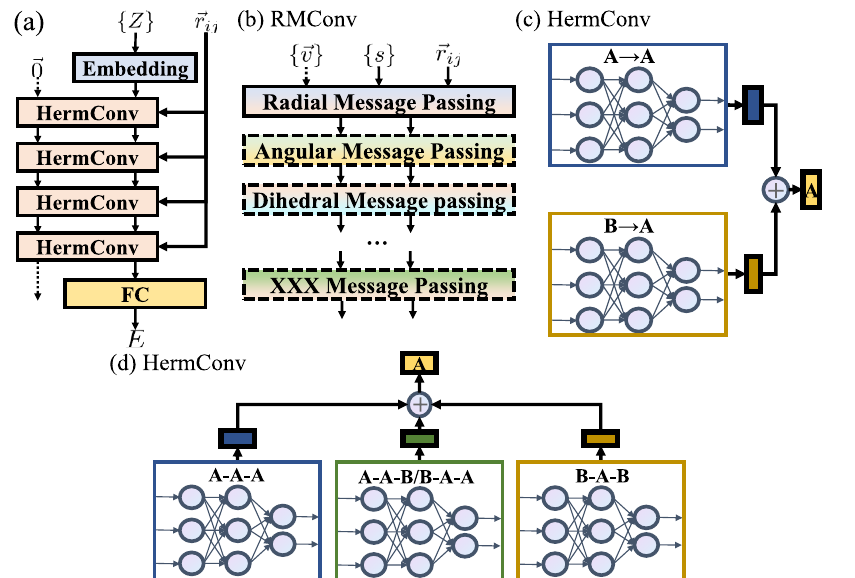
Fig. 2 The schematic of the working principle of the entire architecture. a The entire architecture diagram of HermNet where { Z } is the set of atomic numbers, which will be passed through an embedding layer. Initial vectorial node features are all-zero vectors of fi xed dimension. This layer is expected to receive a scalar node feature { s }, a vectorial node feature, and a vectorial edge feature, i.e. relative position vector r and then output an updated scalar and vectorial node feature as the inputs of the next layer. The fi nal scalar node features will be passed to a global pooling layer as feature of the graph. With the graph-level feature passing to a sequence of fully connected layers, the target to predict is achieved. b Sub-network for processing related subgraphs, i.e., homogeneous digraphs. The layer is composed of message passing layers hierarchically, such as radial message passing layer for two-body interactions, angular message passing layer for three-body interactions, and so on. Related message passing layers will be truncated according to the level of interactions to be modeled. The features or/and message passing layers with dotted line should be introduced in accordance with requirements. Several sub-networks which model different relations compose a single heterogeneous relational message passing layer. When the interactions are truncated to two-body interactions, the entire framework is termed HPNet. c and d are the schematic diagrams of HermConv module of HPNet and HTNet (HVNet), respectively. RMConv modules for different relations constitute the HermConv module. c Sub-network in HPNet for A-type when the system contains only two kinds of elements, speci fi cally, A- and B-type. d The hidden states of A-type vertex derive from a sub-network that is truncated to three-body interactions for corresponding relations. The colors of the networks for different three-body interactions represent the parameters. If these colors are the same, which means the parameters are shared in all these three networks, the HermNet is termed HVNet. If not, then the HermNet is termed composed of several message passing layers, termed HermConv layers, which model interactions hierarchically. The RMConv modules (Fig. 2b) of different relations constitute the HermConv module (Fig. 2c, d). We introduce three variants of HermNets: heterogeneous pair networks (HPNet), heterogeneous triadic networks (HTNet), and heterogeneous vertex networks (HVNet). A HPNet layer for central nodes of A-type is displayed in Fig. 2c, where all the sub-networks with A-type destination contribute to the local environment of A-type node. A HermNet layer for HVNet and HTNet is displayed in Fig. 2d. If the parameters of its sub- networks [RMConv, see Fig. 3] are shared for the same kinds of central nodes, this HermNet framework is referred to as HVNet. When the parameters are not shared, this HermNet framework is an HTNet. We only test and report HVNet ’ s performance in the following sections, as the other two models (HPNet and HTNet) have high complexity and will take more training time and data points for a proper assessment. Most machine learning frameworks for MD simulation only take into account the interatomic distances in feature engineering, ignoring the bond angle information, which is an important characteristic of both molecules and crystals. In principle bond angle can be deduced from interatomic distances. However, it is advantageous to explicitly include bond angle information in feature engineering to achieve better performance. Directional message passing networks (DimeNet) 20,21 innovatively introduced three-body interactions explicitly by combining radial and angular information from the edges of the original graph and the corresponding line graph, respectively. PAINN 22 is a rotationally